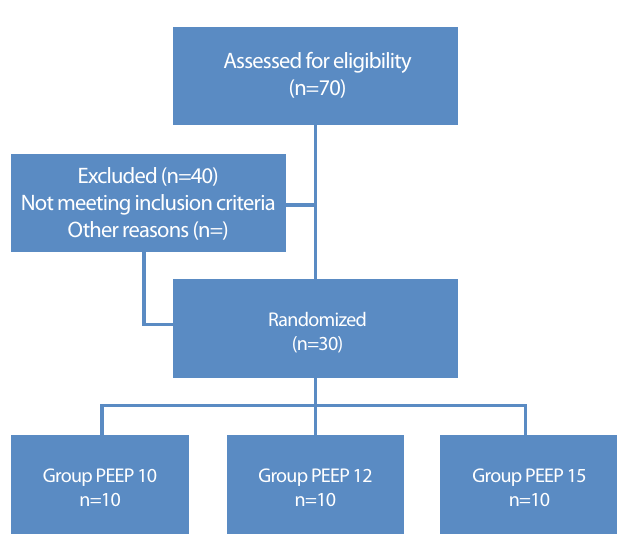
Fig. 1 - Patient selection flowchart.